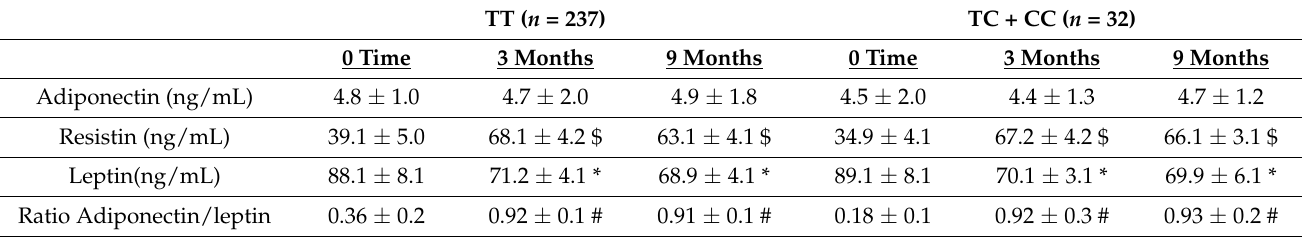
Table 4. Circulating adipocytokines at three times (basal and 3 and 9 months after the intervention) (mean ±